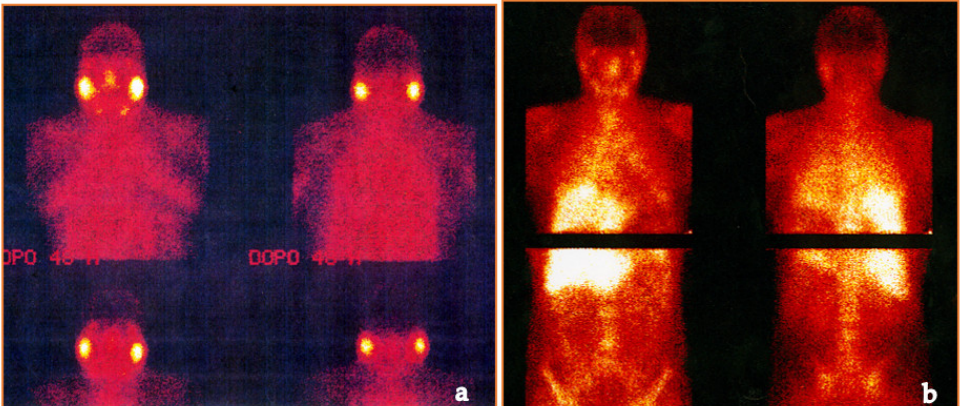
Figure 6. 67 Gallium total body scintigraphy showing increased uptake at salivary glands ( a ) and liver ( b ).